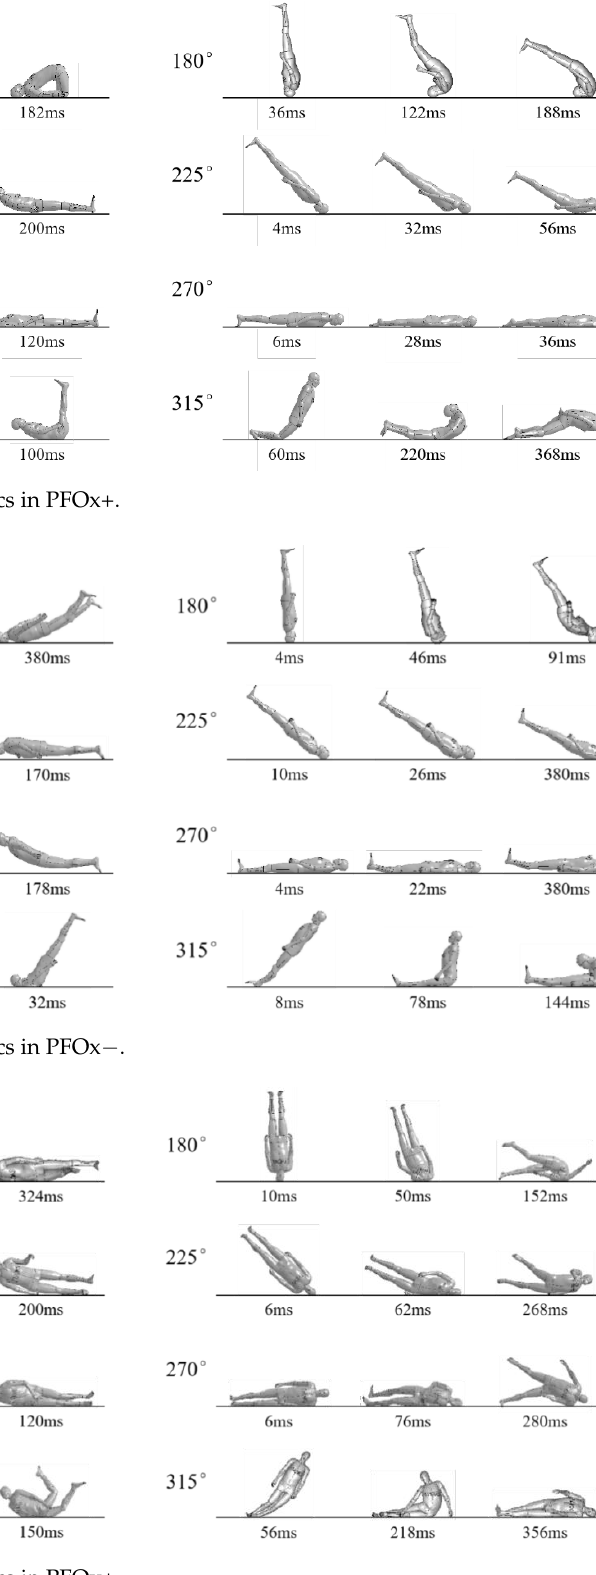
Figure 5. Typical landing kinematics in PFOy+.